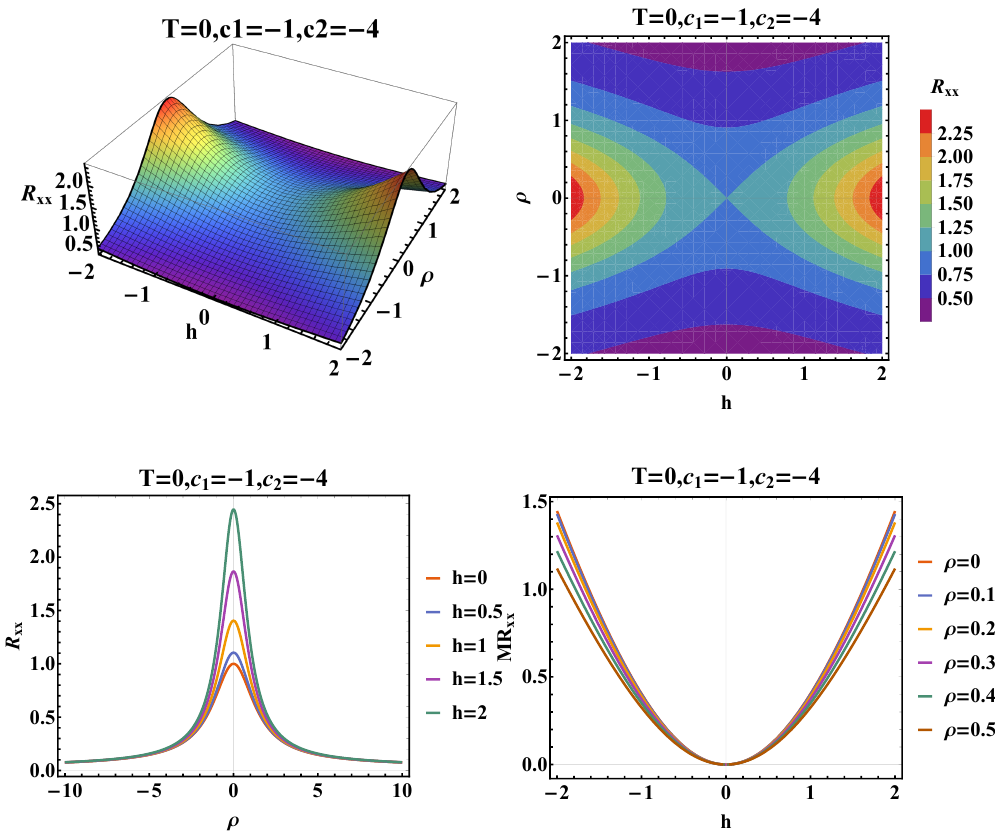
Figure 5 . Upper left: R xx as a function of ρ and h . Upper right: contour plot of R xx . Lower left: R xx vs ρ with h = 0 , 0 . 5 , 1 , 1 . 5 , 2 . Lower right: MR xx vs h with ρ = 0 , 0 . 1 , 0 . 2 , 0 . 3 , 0 . 4 , 0 . 5 . We set T = 0 , c 1 = − 1 , and c 2 = − 4